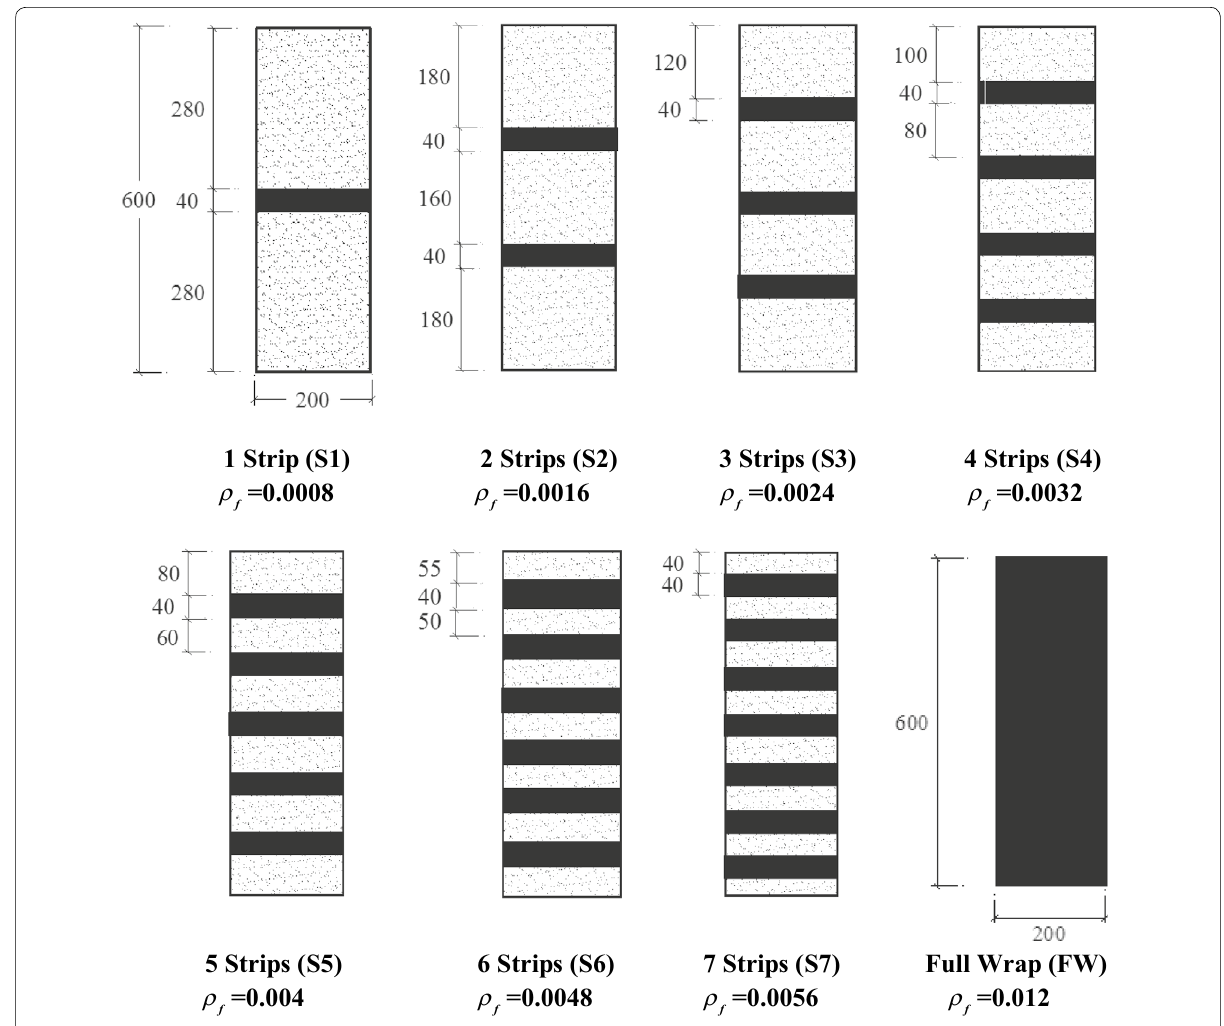
Fig. 2 FRP wrap layout on circular columns (all dimensions are in mm; 1 mm